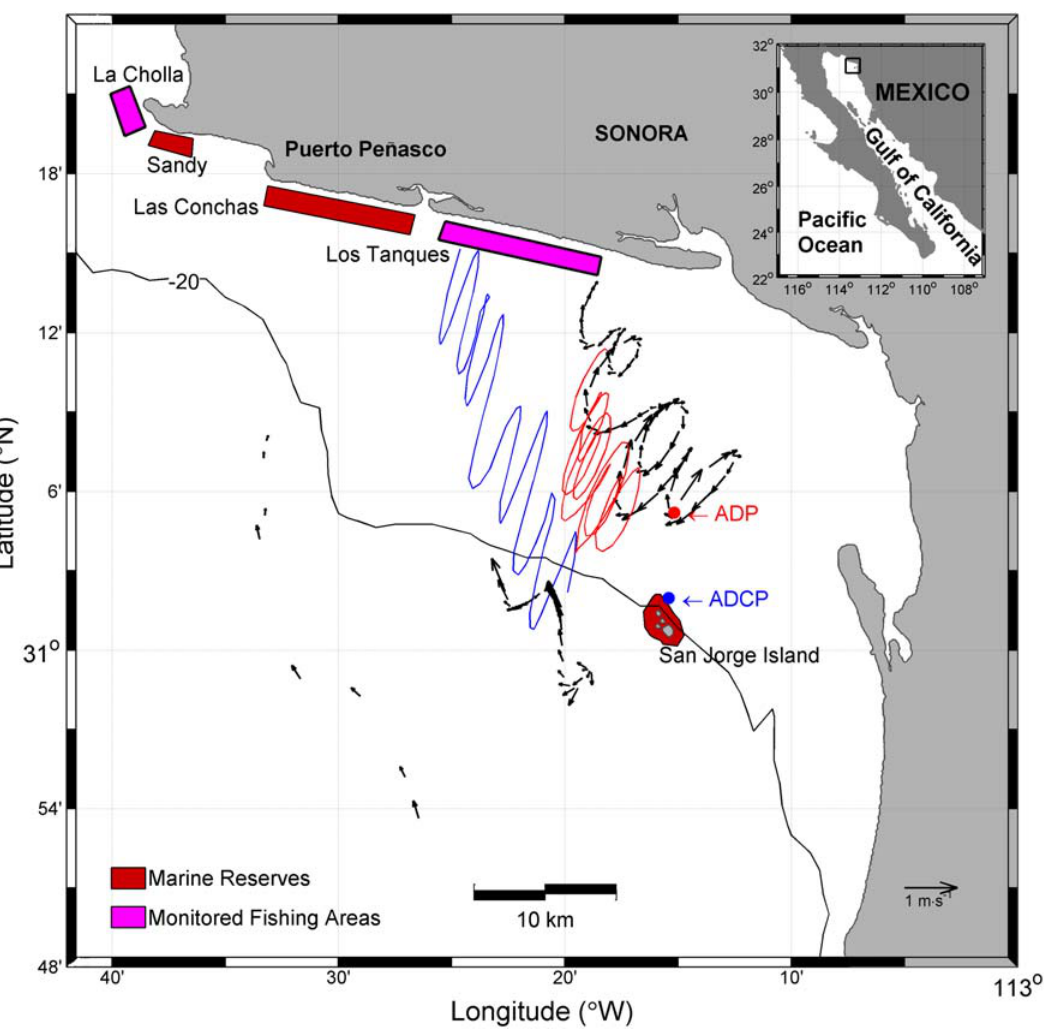
Figure 1. Location of reserve network, monitored fishing areas, and observations of regional currents. The three diagrams in the center represent: track and velocity of a surface drifter (in black), progressive vector diagram (PVD) from velocity measured 15 m above the bottom at ADCP (Acoustic Doppler Current Profiler) site (in blue, bottom at 25 m), and the PVD from velocity measured 15 m above the bottom at ADP (Acoustic Doppler Profiler) site (in red, bottom at 18 m). Both PVDs have been shifted west for clarity. These three diagrams are made with hourly-mean data for the period 19:00:00 (UT) July 12 to 00:10:00 July 16 2006. The black arrows close to the 20 m isobath represent interpolated half-hourly data from a drifter drogued at 15 m, from 03:00 to 22:30, July 7 2006. The most offshore arrows are 6-hourly drifter data from the same drifter, from 18:00 June 24 to 12:00 June 25 2006 (see Fig. S1 and S2 for additional drifter trajectories and PVDs).